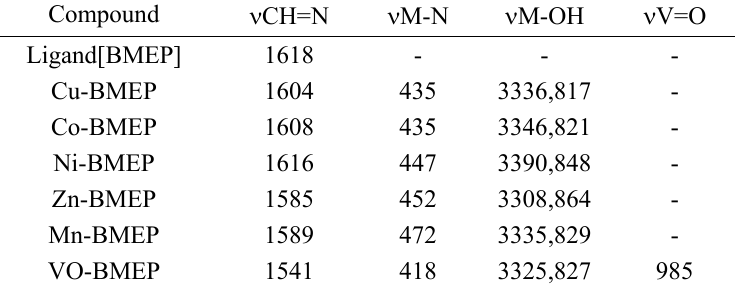
Table 2. Characteristics IR bands (cm -1 ) of the compounds